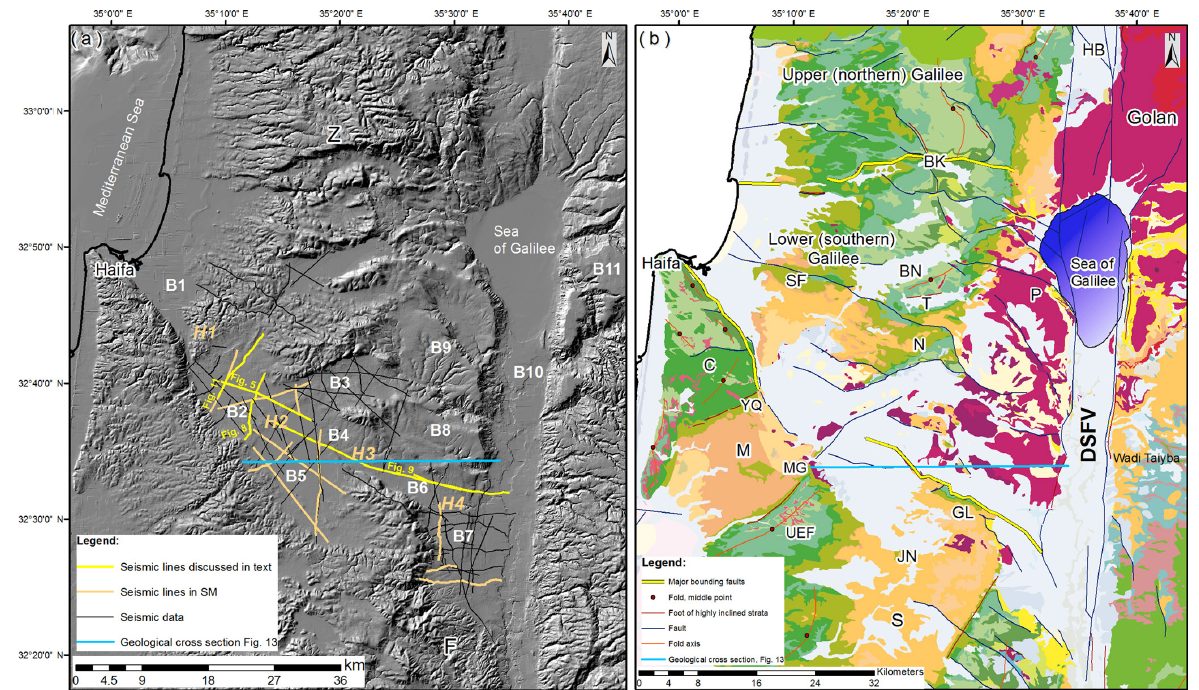
Figure 3. Location map of the study area, Sinai subplate. (a) Location of the multichannel seismic reflection profiles used in this study on a shaded relief digital elevation model (DEM; Sneh et al., 2000b). Local names of the basins and the structural highs are abbreviated